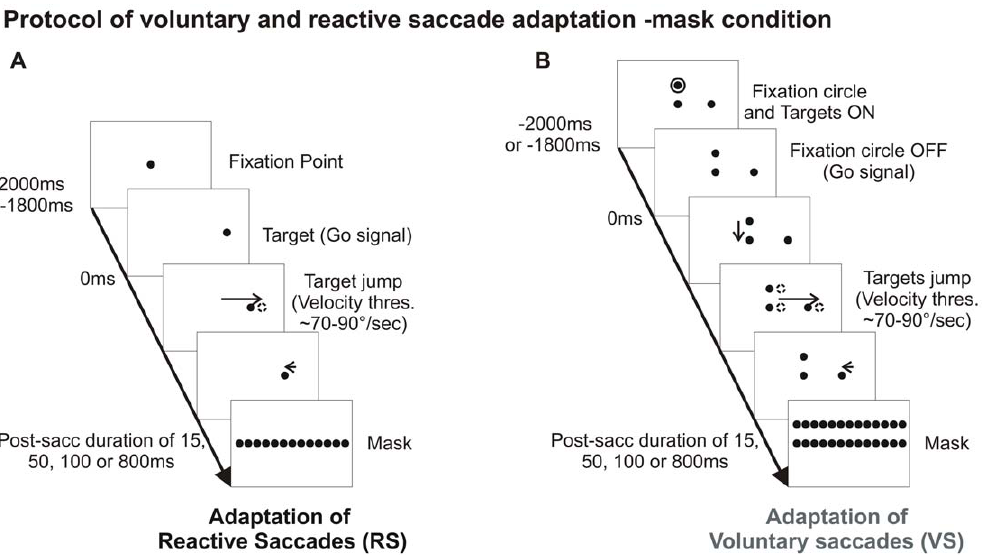
Figure 1. Protocol of reactive and voluntary saccade adaptation in the mask condition (only rightward trials represented). Vertical and long horizontal arrows indicate primary saccades and short horizontal arrows indicate corrective saccades. When a horizontal primary saccade is detected (threshold of 70–90 u /sec) the target or the display jumped, respectively in the reactive and voluntary saccade adaptation. Fifteen, 50, 100 or 800 ms after saccade offset, the visual display is replaced by a mask in the mask condition. In the no-mask condition, 15 or 50 ms after saccade termination, a blank screen replaced the visual display.